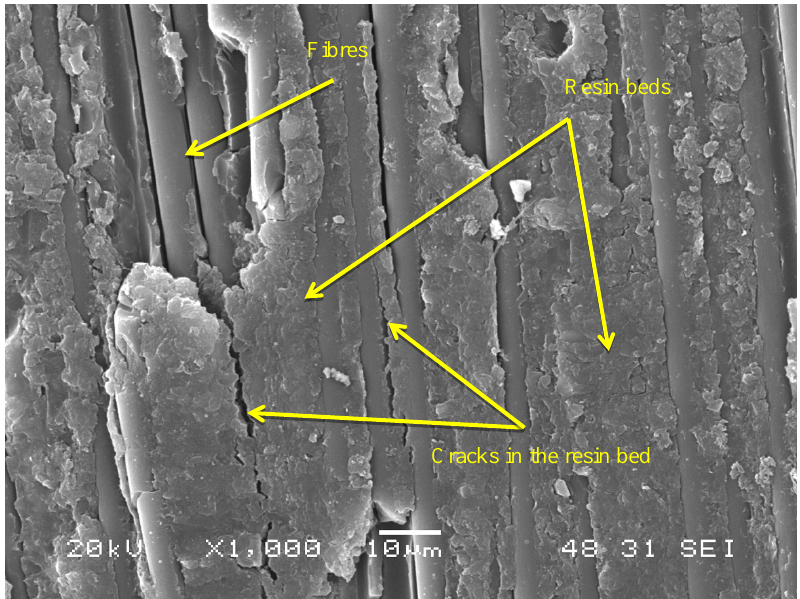
Figure 7. Presence of resin beds.